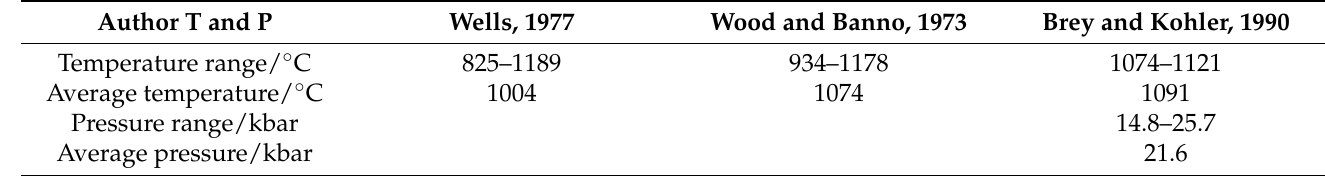
Table 6. Comparison of different temperatures and